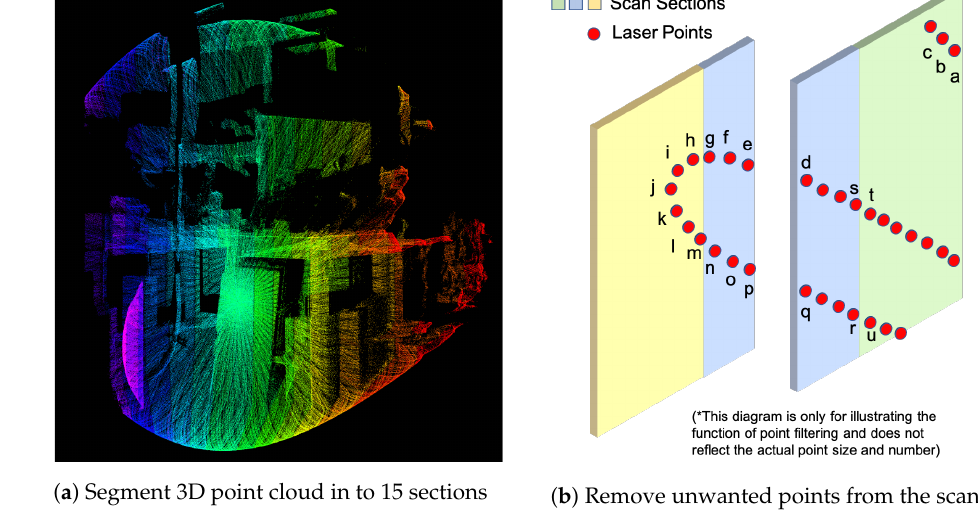
Figure 5. Scan sections and point